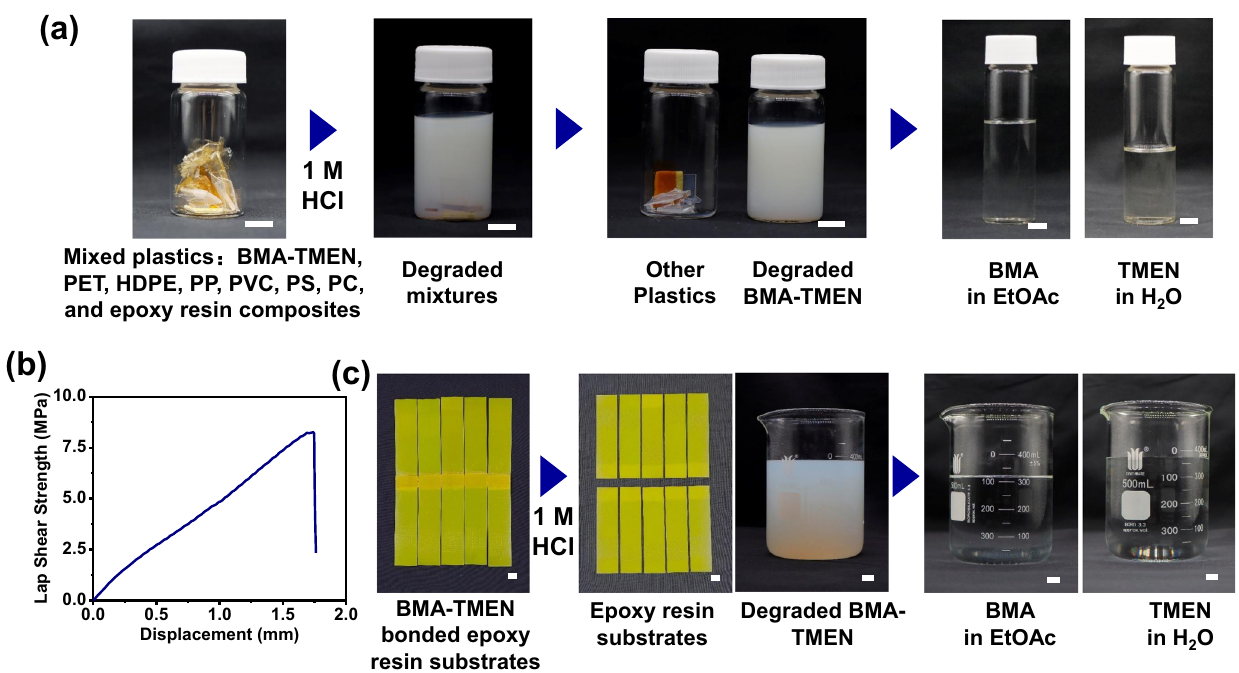
Fig. 5 | Selective chemical recycling of BMA-TMEN. a Depolymerization and recycling process of BMA-TMEN from the mixed plastic wastes containing PET, HDPE, PP, PVC, PS, PC and epoxy resin composites (scale bar: 1cm). b Lap shear